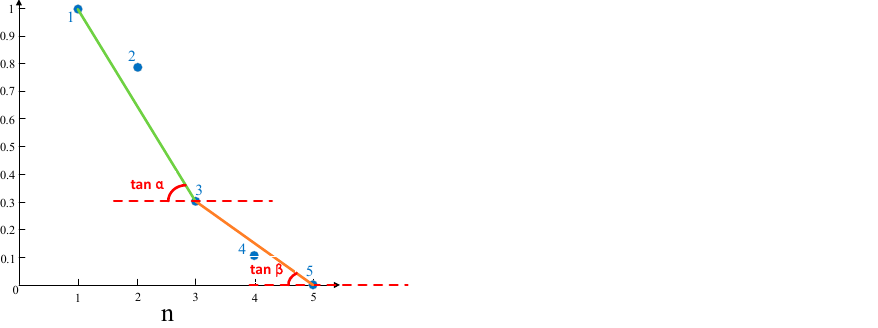
Figure 3. Automatic selection of clustering centers via tangent value calculation.